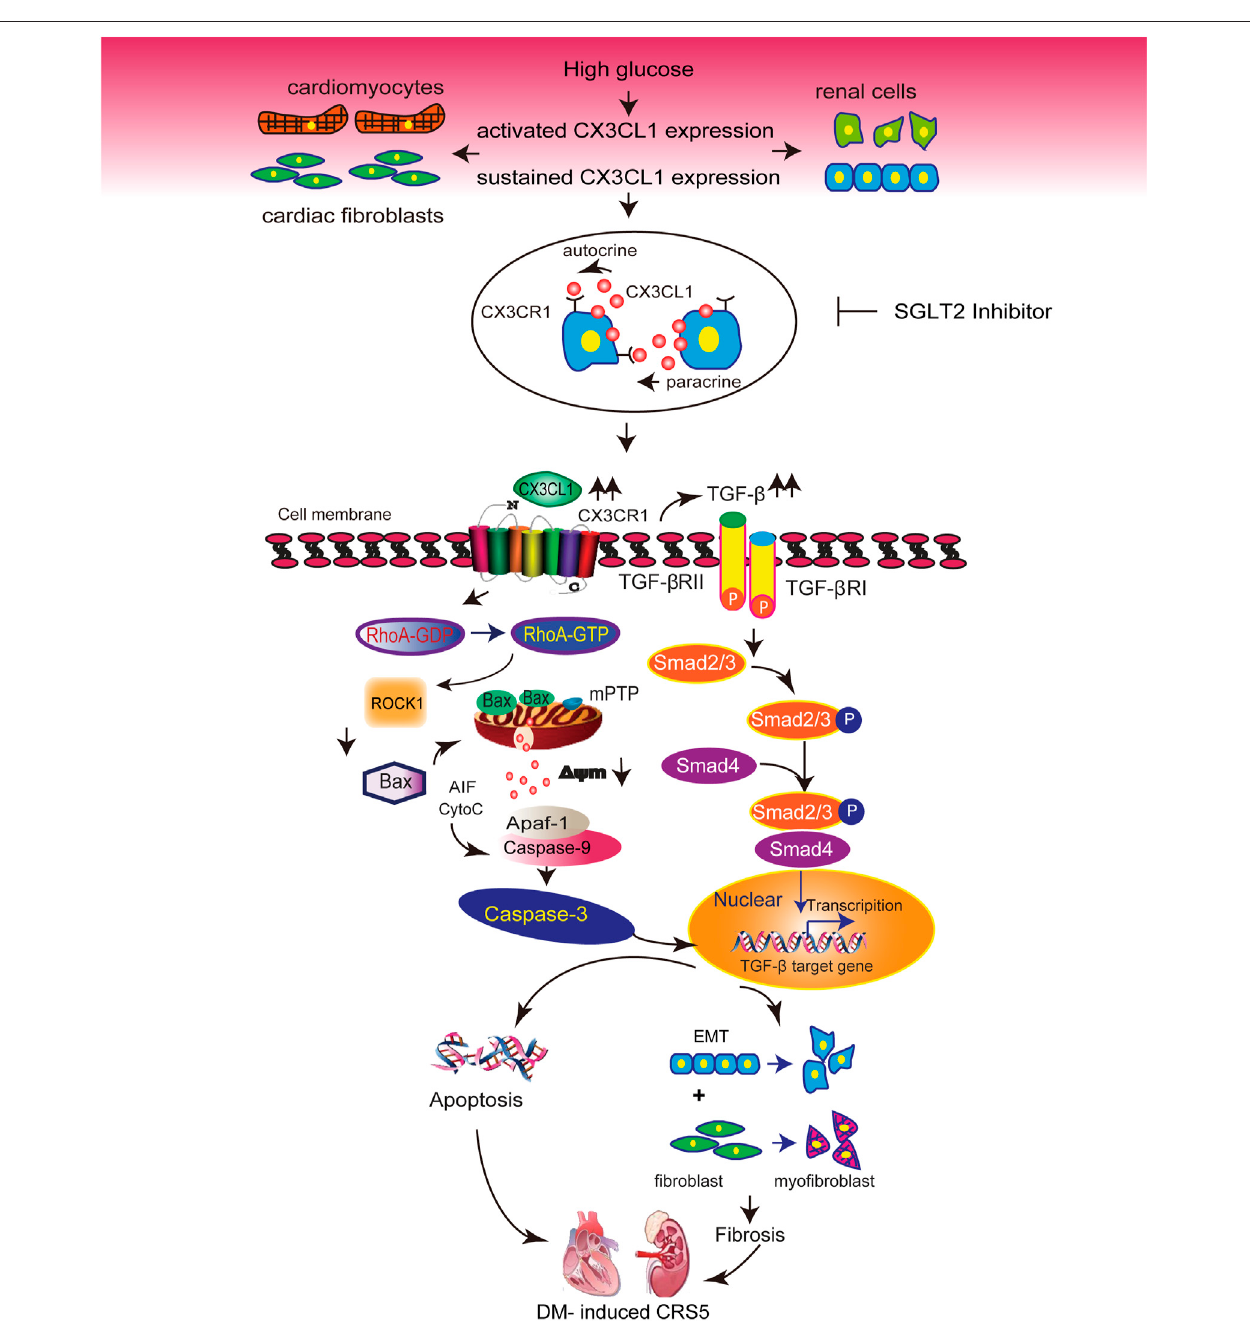
FIGURE8| IllustrationofthemolecularmechanismsbywhichCX3CL1promotescardiorenaldysfunctioninducedbydiabetics.CX3CL1expressionisupregulated in cardiac and renal cells by a high glucose environment. Persistent high CX3CL1 expression accelerates the mitochondrial apoptotic pathway through activation of RhoA/ROCK1-Bax signaling. In addition, CX3CL1 regulates fi broblast and epithelial cell phenotypic trans-differentiation through activation of TGF- β /Smad signaling. CX3CL1leadstotheonsetofcardiorenaldysfunctionindiabetes-inducedcardiorenalsyndrometype5(CRS5)duetoitsproapoptoticandpro fi broticeffects,while SGLT2 inhibitor could improve CRS5 at least partially by repressing CX3CL1 expression.